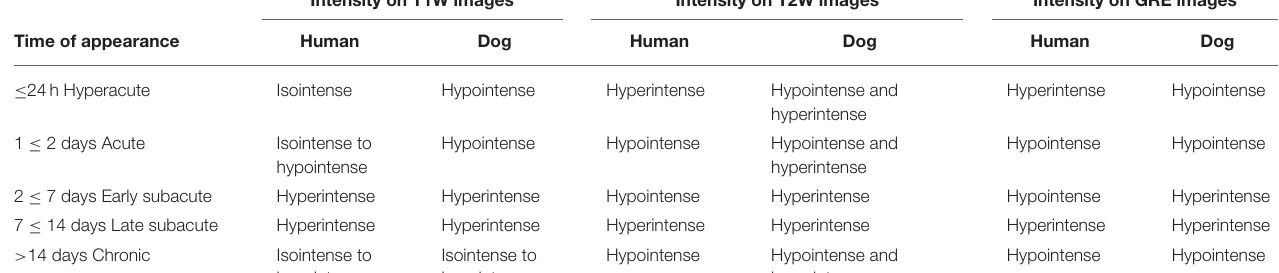
TABLE 1 | The temporal evolution of the MRI signal characteristics of intracranial hemorrhage reported in dogs compared to that observed in humans (3, 28). Intensity on T1W images Intensity on T2W images Intensity on GRE images